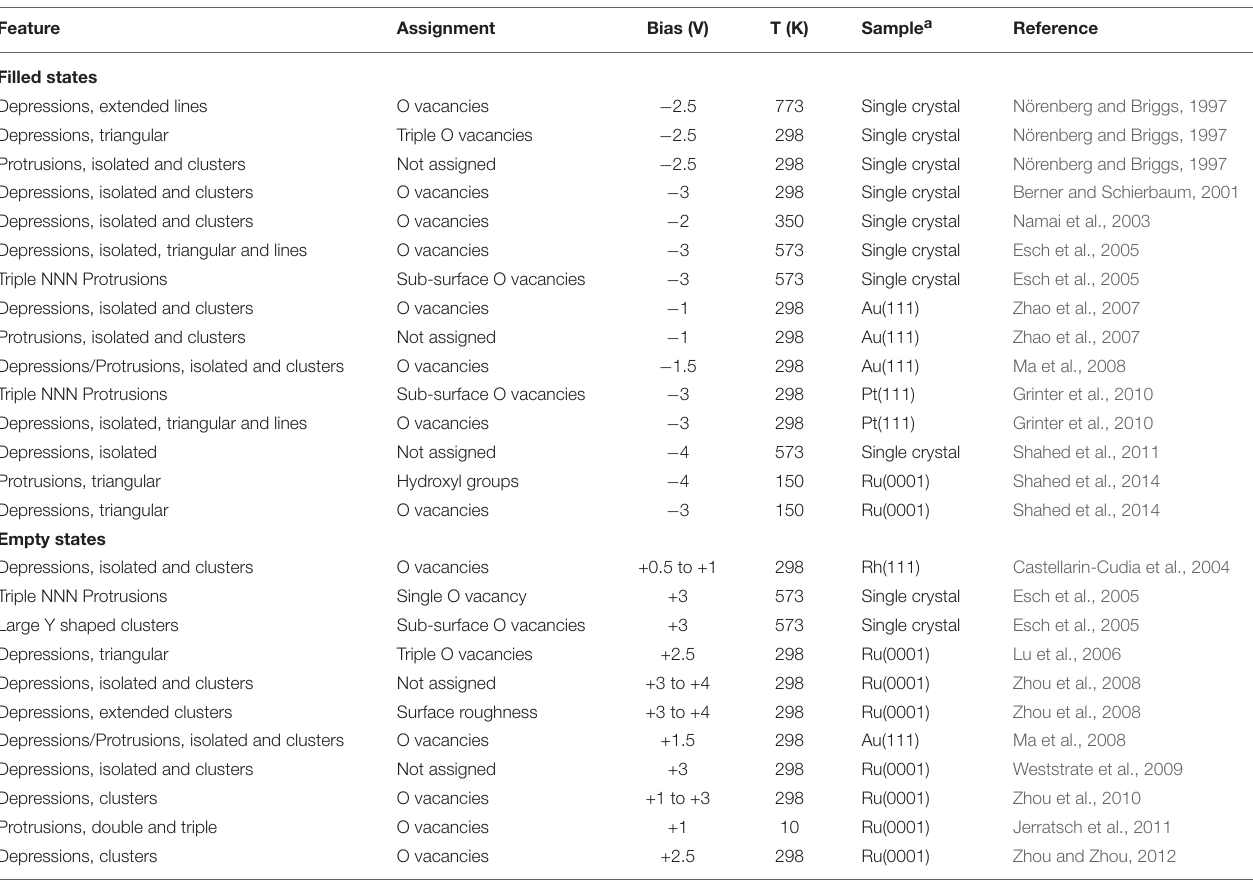
TABLE 1 | Summary of experimentally observed STM features on ceria